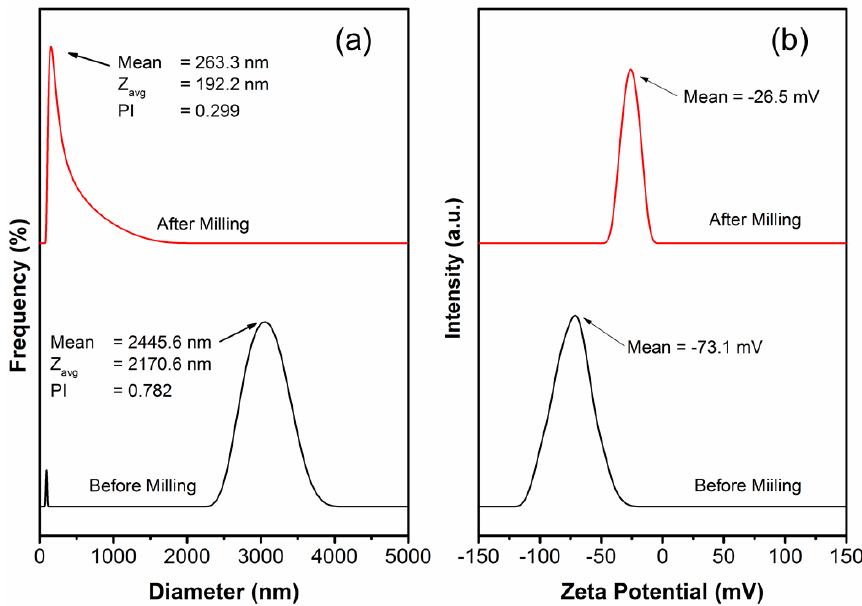
Figure 2. ZnO − SiO 2 NP suspension before and after bead milling: ( a ) particle size distribution and ( b ) zeta potential. ( b ) zeta